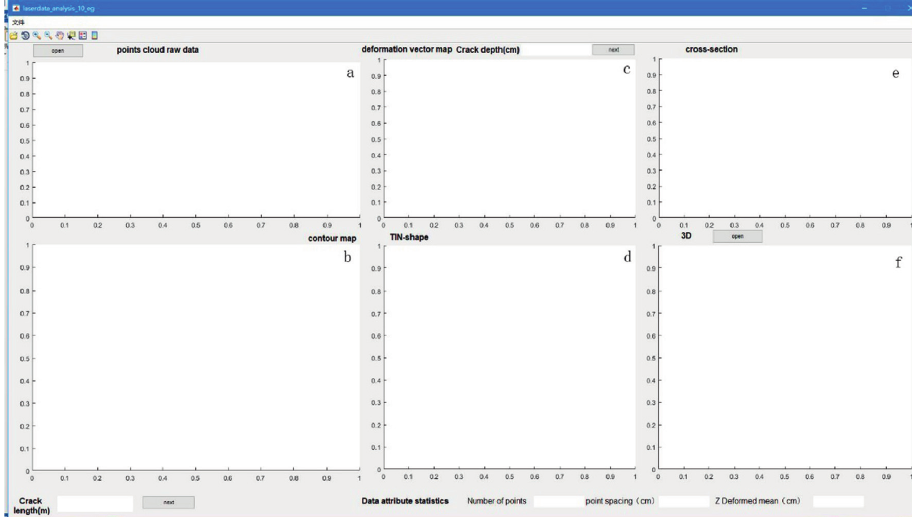
Figure 5: Analytical model interface.